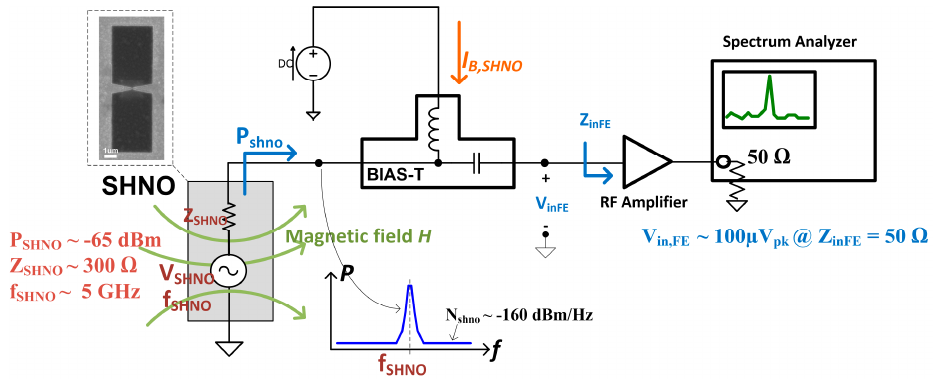
Figure 2. SHNO parameters, simplified scheme of the oscillator under test, at a fixed external magnetic field and I B,SHNO , and the measurement setup are shown.